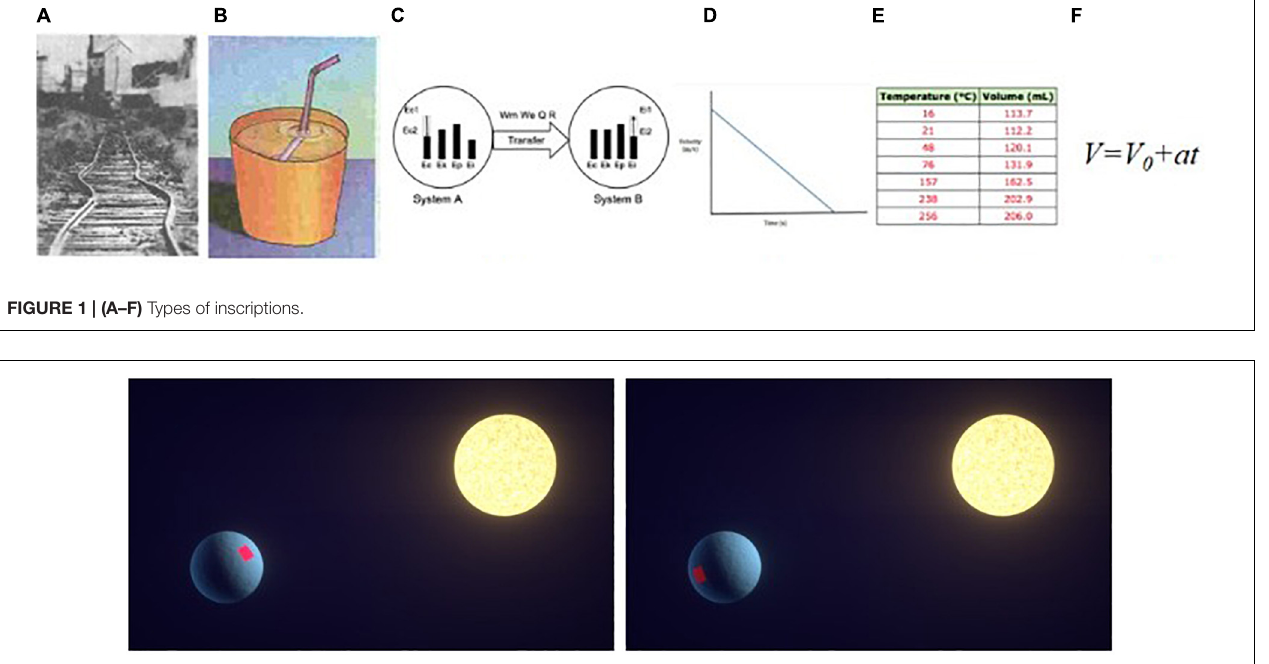
FIGURE 2 | Two snapshots assigning Earth’s